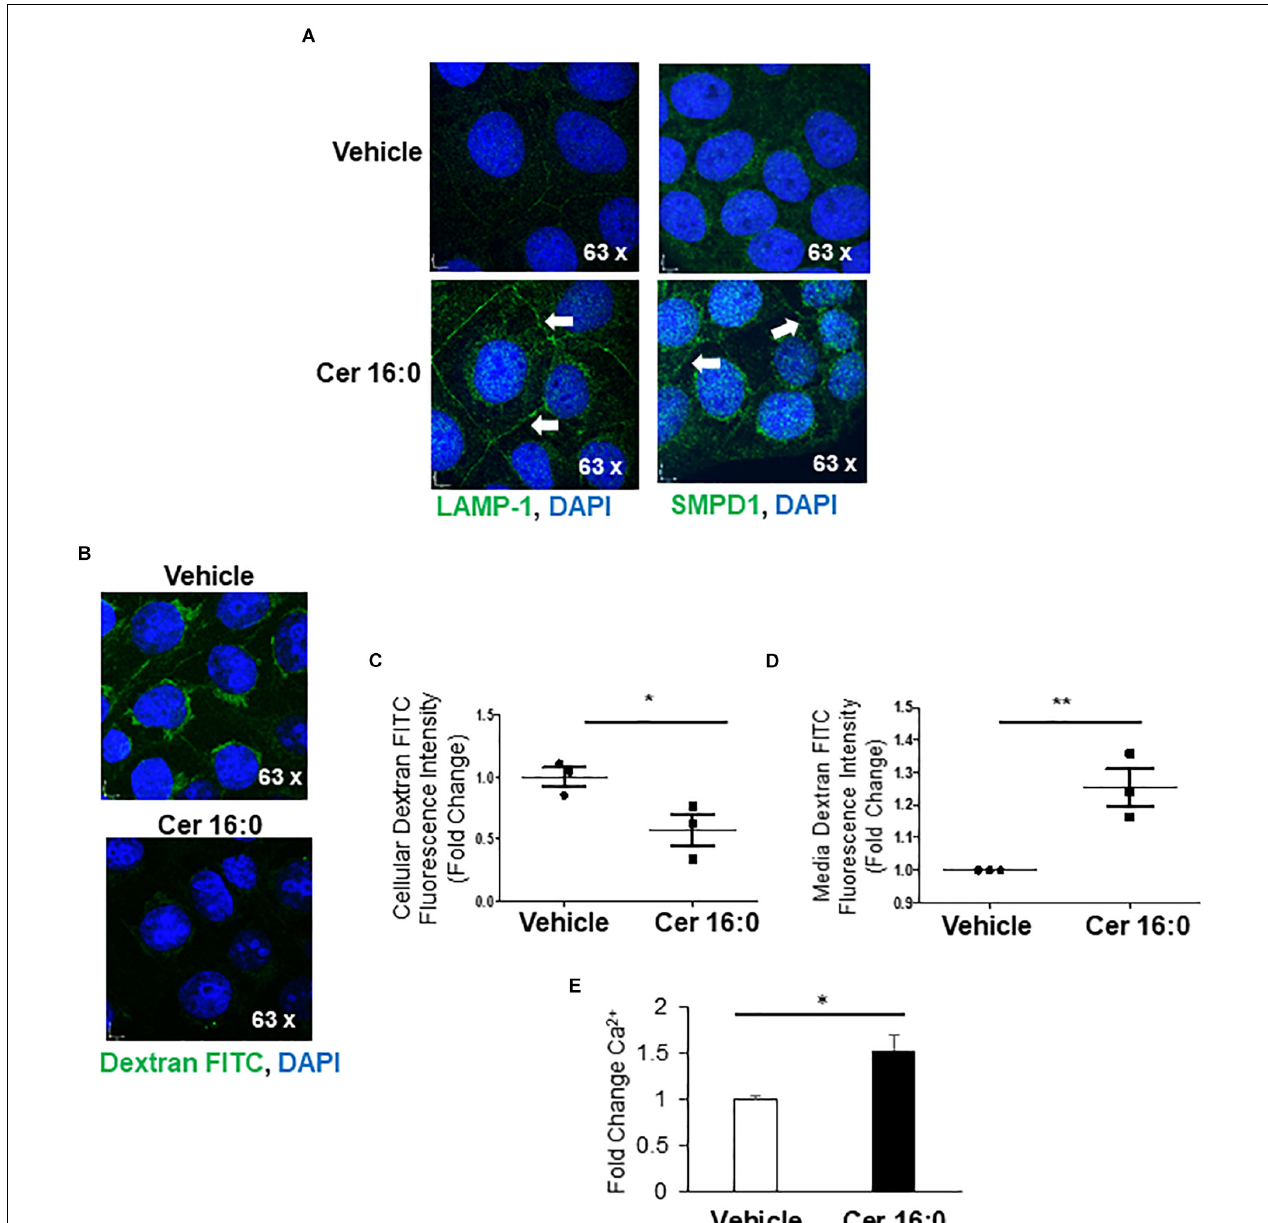
FIGURE 6 | Ceramide triggers lysosomal exocytosis in JEG3 cells. (A) IF images for LAMP-1 and SMPD1 in JEG3 cells following exposure to 20 µ M CER 16:0 or EtOH vehicle. (B) IF images of FITC-dextran (green) loaded JEG3 cells following exposure to 20 µ M CER 16:0 or EtOH vehicle. Nuclei: DAPI (blue). (C) Fold change in fluorescence intensity of FITC-dextran in JEG3 cells treated with 20 µ M CER 16:0 or EtOH vehicle ( N = 3 separate experiments; * P < 0.05 compared to vehicle). (D) Fold change in fluorescence intensity of released FITC-dextran in media of JEG3 cells treated with 20 µ M CER 16:0 or EtOH vehicle ( N = 3 separate experiments; ** P < 0.01 compared to vehicle). (E) Fold change variation of intracellular Ca 2 + content of JEG3 cells treated with 20 µ M CER 16:0 versus EtOH vehicle. Data are expressed as mean ±